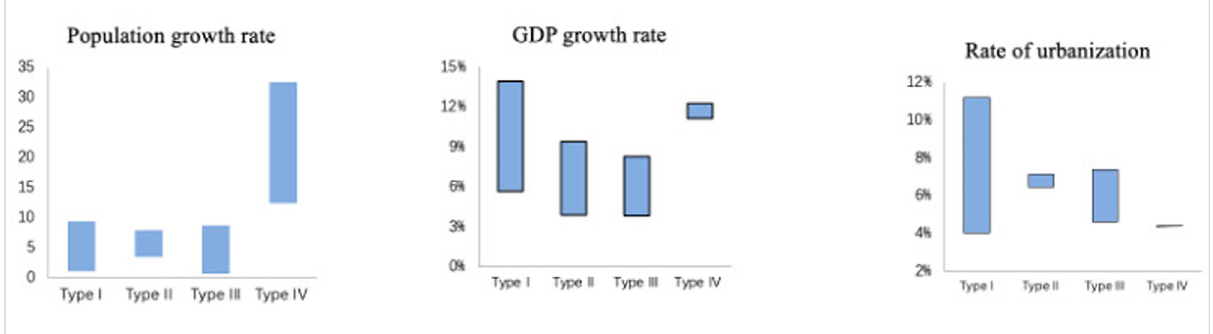
FIGURE 5 Static index characteristics of various cities.